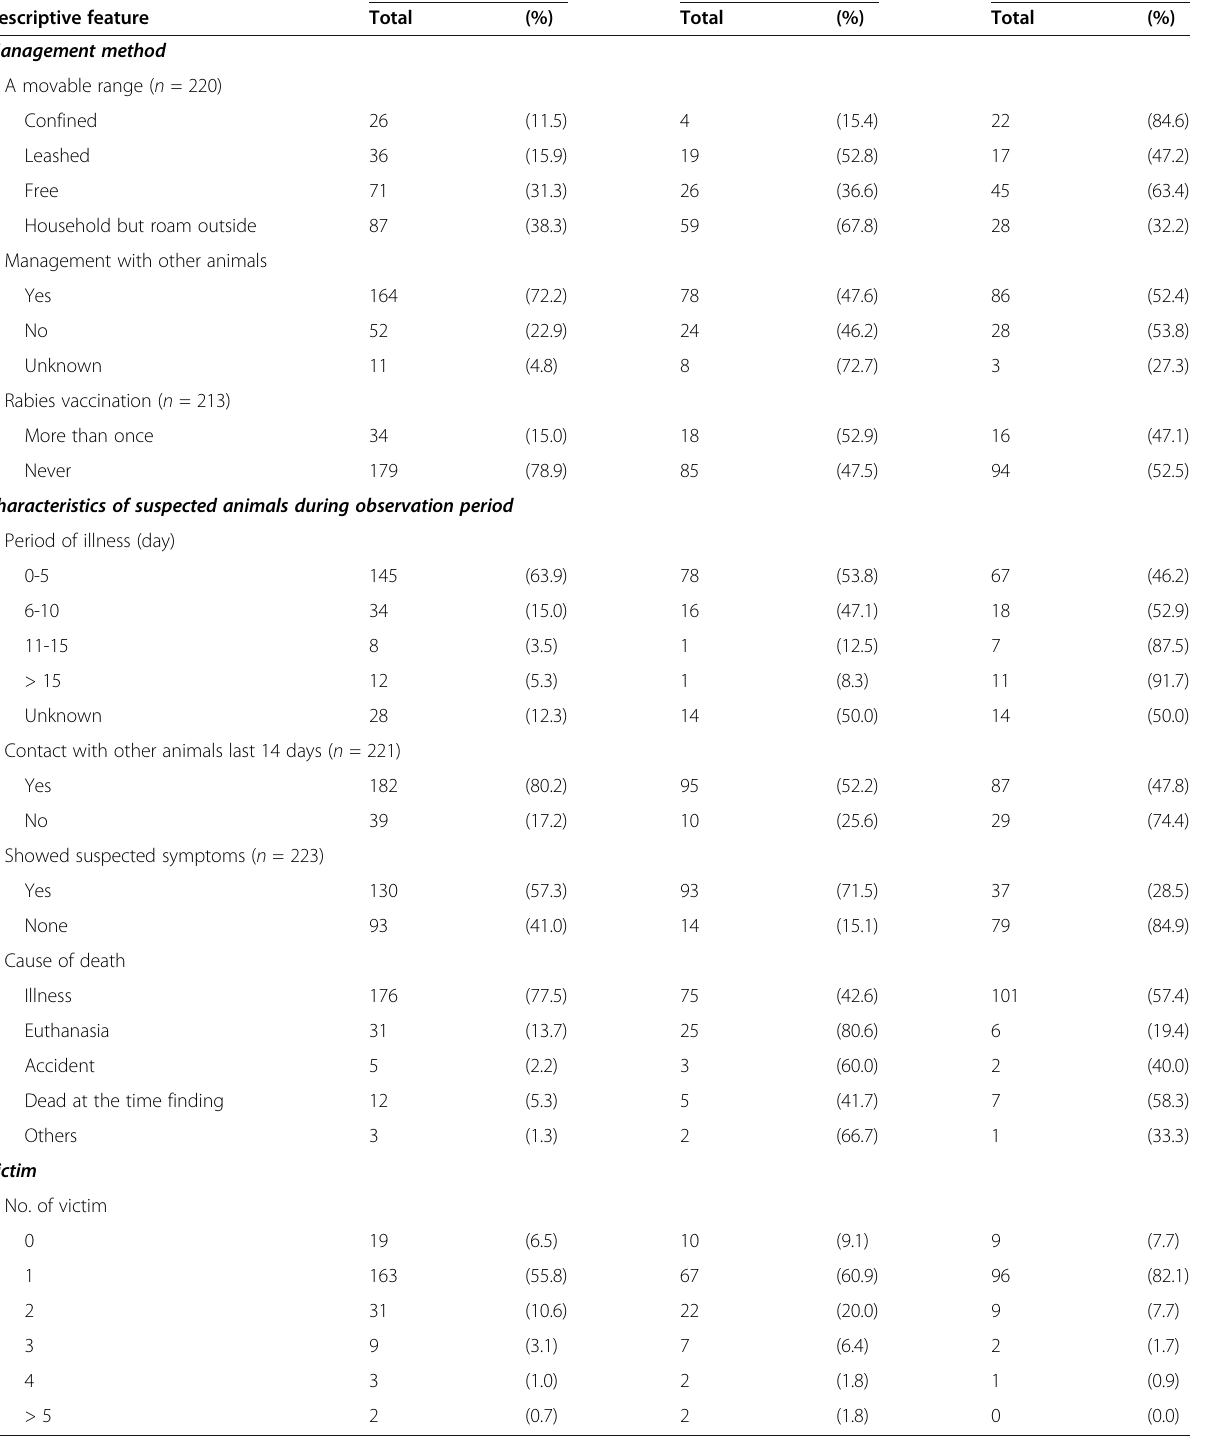
Table 2 Management method, characteristics of suspected animals during observation period, and number of victims of 227 suspected animals Total Positive Negative Descriptive